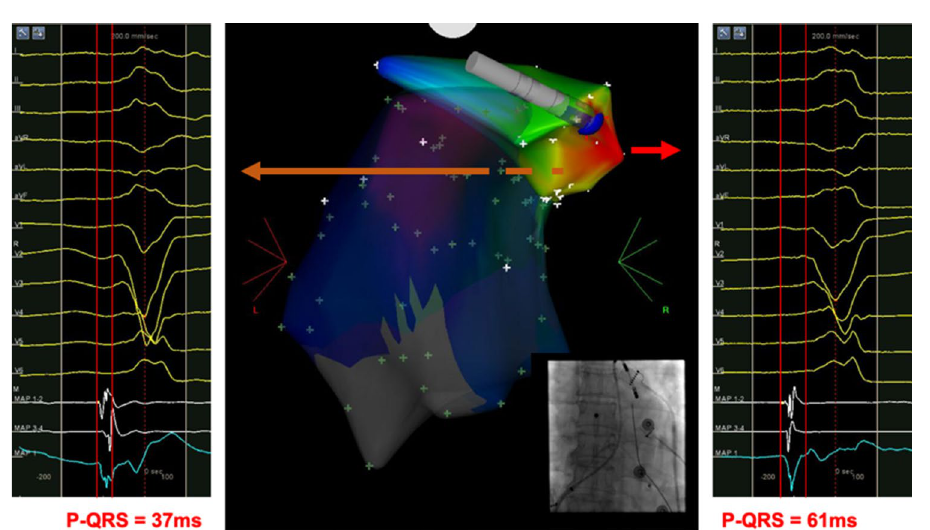
Figure 5. An example of successful ablation in the PSC. In the left panel, the local electrogram of the site with earliest activation time below the PV is presented. In the middle: the CARTO activation map of a PVC in the posterior–anterior view is shown, while fluoroscopic view in the anterior–posterior view is also presented in the bottom right corner. The blue dot points to the site where ablation led to the elimination of PVCs. The local electrogram of the site with earliest activation time during PSC mapping is presented in the right